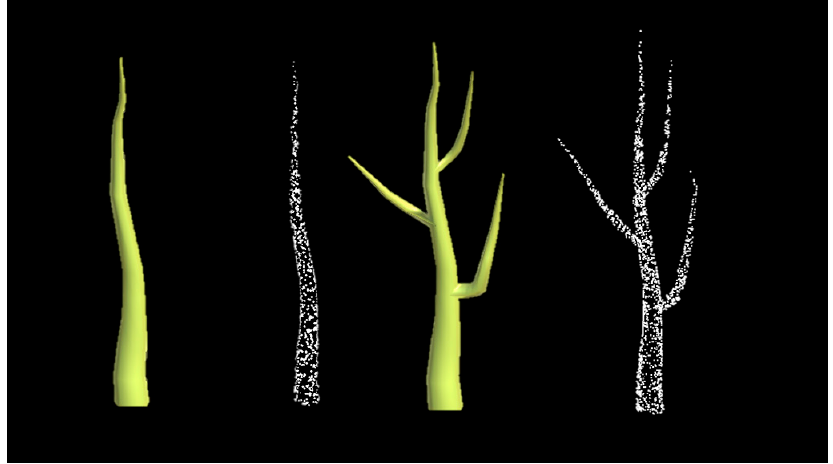
Figure 2. 3D models and the corresponding point clouds of two types of artificial stems. ( Left ): the ”stem” model and its point cloud. ( Right ): the “stem with branches” model and its point cloud. Point Cloud Library (PCL) [30] and Visualization Toolkit [31] were used to resample 3D models back to a point cloud. Once a 3D model was resampled, we had a pair of a 3D